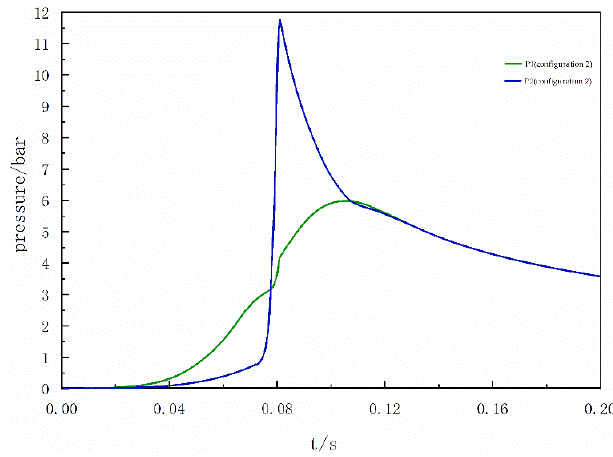
Figure 11. Waveform of explosion pressure of simulation.